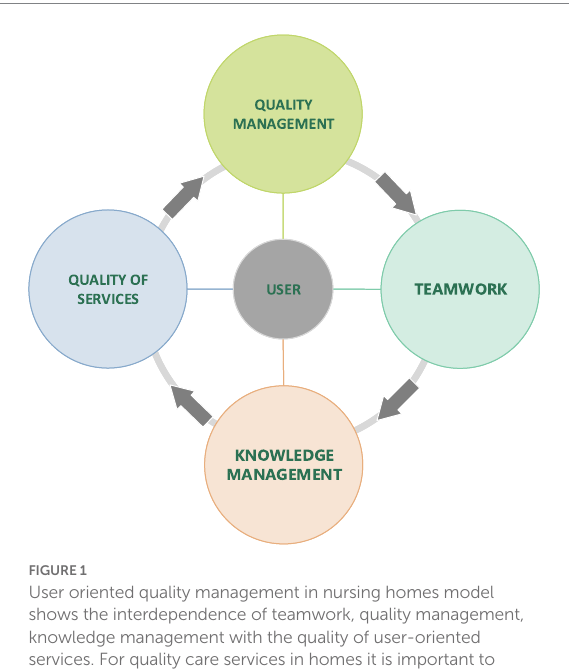
FIGURE 1 User oriented quality management in nursing homes model shows the interdependence of teamwork, quality management, knowledge management with the quality of user-oriented services. For quality care services in homes it is important to know the habits of the user, his wishes and the implementation of person-centered